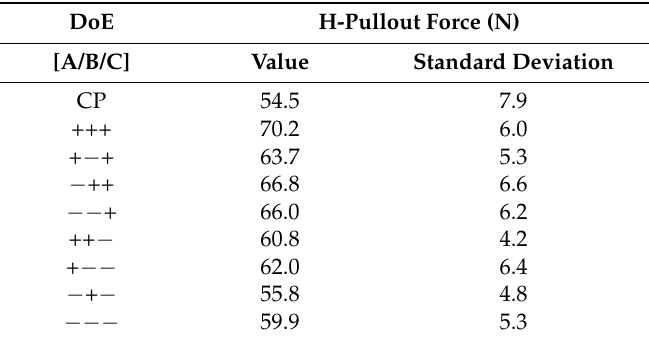
Table 6. DoE results for rayon